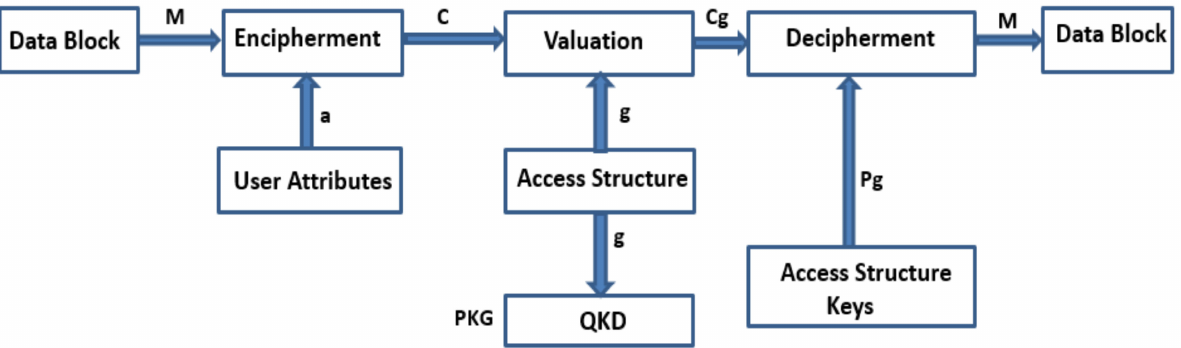
Figure 2. Exemplification of the QHCPABE scheme work